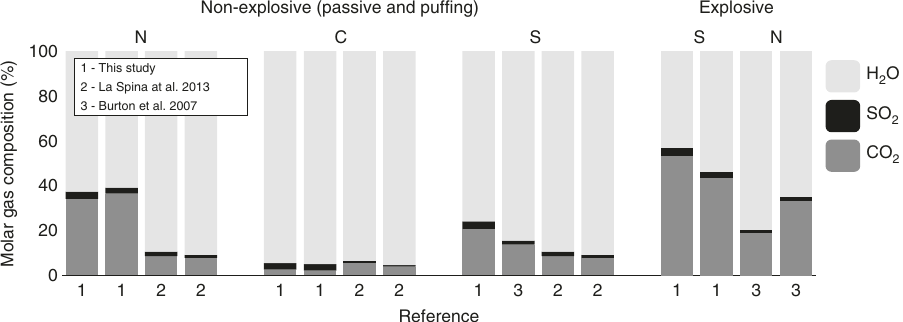
Fig. 7 Comparison of molar gas compositions with previous studies. Comparison of molar gas compositions (mol %) of major species measured in this study, to previously published data for both non-explosive (passive degassing/puf fi ng) and explosive